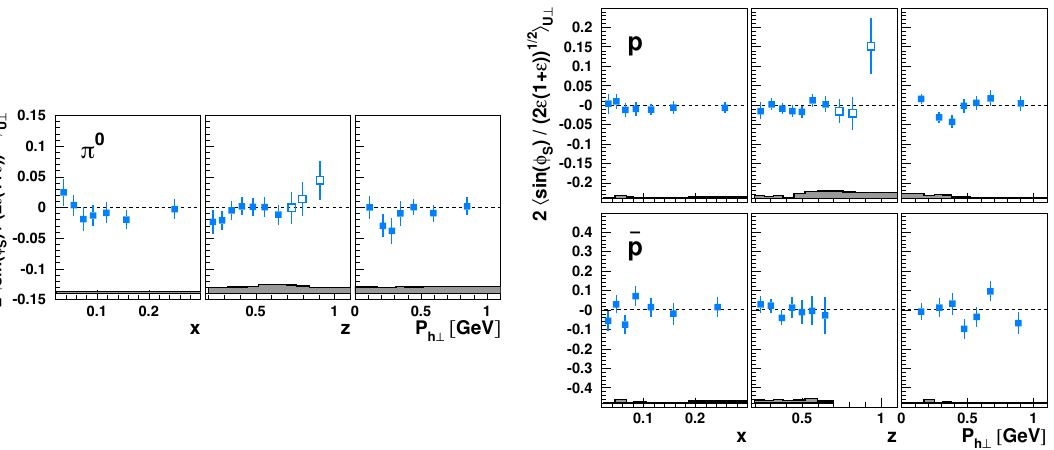
p Figure 28 . The 2 h sin( φ S ) / 2 (cid:15) (1+ (cid:15) ) i h amplitudes for π 0 (left), protons, and antiprotons (right) U ⊥ presented either in bins of x , z , or P h ⊥ . Data at large values of z , marked by open points in the z projection, are not included in the other projections (no such high- z points are available for an- tiprotons due to a lack of precision). Systematic uncertainties are given as bands, not including the additional scale uncertainty of 7.3% due to the precision of the target-polarization